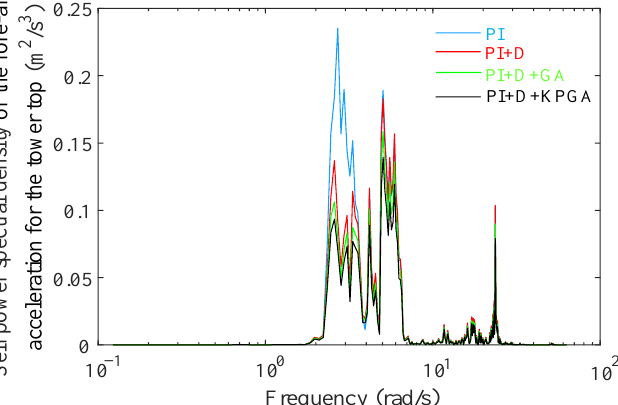
Figure 11. Self-power spectral density of the fore-aft acceleration for the tower top.